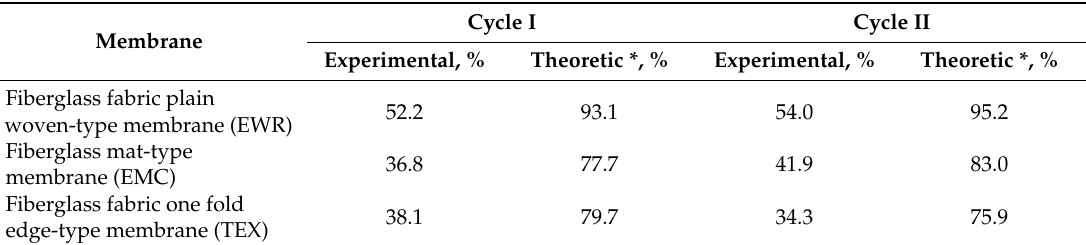
Figure 3. Removal efficiency of organic content: ( a ) fiberglass fabric plain woven-type membrane (EWR); ( b ) fiberglass mat-type membrane (EMC); ( c ) fiberglass fabric one fold edge-type membrane (TEX). Table 2. Comparison of the photocatalytic degradation efficiency after 30 min of irradiation.